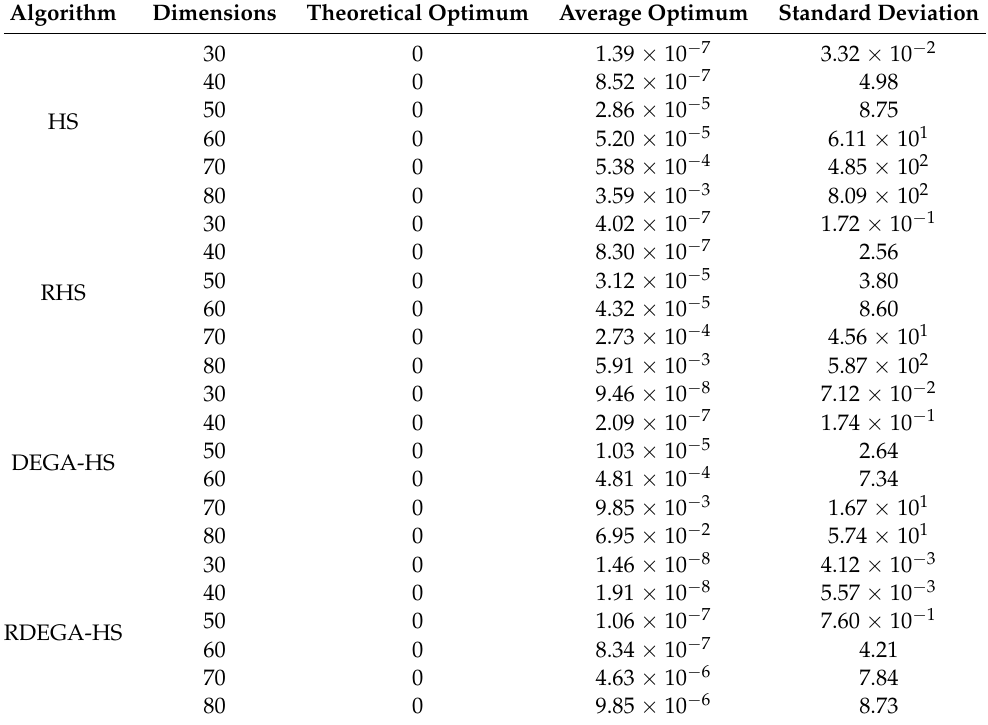
Figure 6. Change in average optimal fitness value of Rastrigin function with number of iterations. Table 6. Results of the Rastrigin function under different optimization